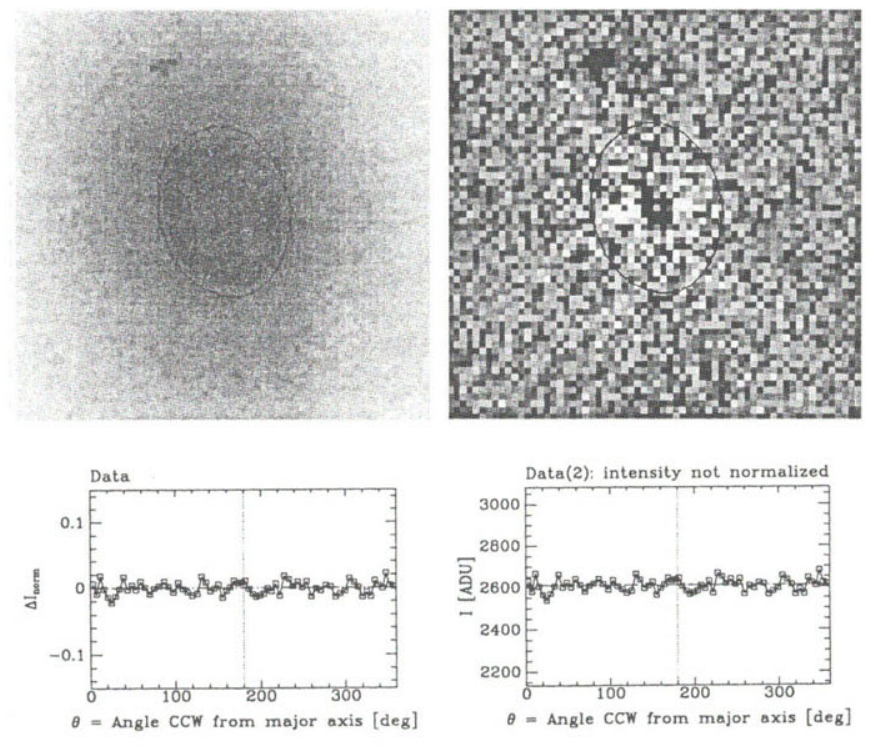
Fig. 5. Top: Original and residual images of the pure E galaxy, with a single ellipse at a = 2.6 kpc (r = 2.3 kpc) shown. The images are 13 kpc on the side. The 'Data' plot shows AI noTm versus 9 (see text) along the shown